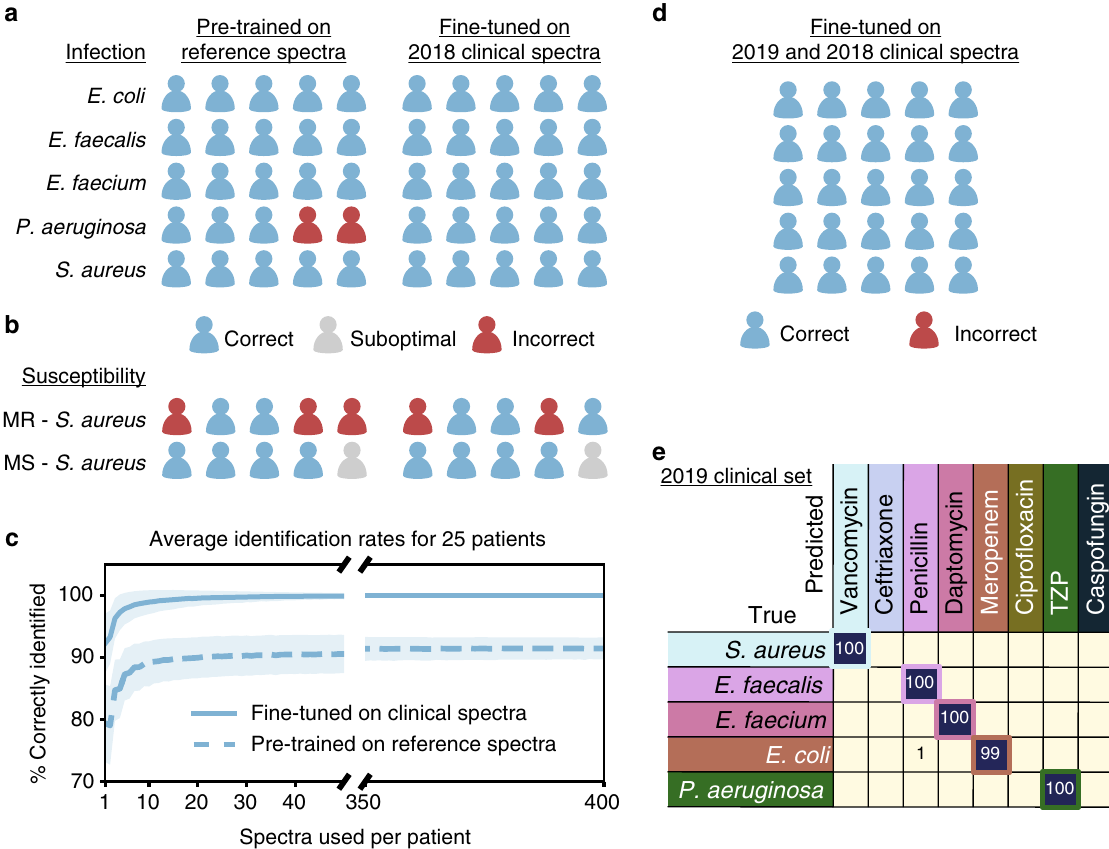
from a single measurement series. All error values reported for tests on the reference dataset are standard deviation values across 5 splits. While a high number of samples is good for ensuring dataset variation, deep learning approaches can still bene fi t from having a high number of examples per sample. When intra-sample variance is high, as we observe for our datasets, a large number of spectra per sample may better represent the full distribution and lead to higher predictive performance.